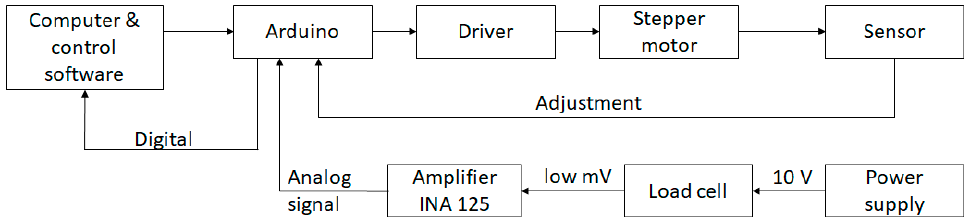
Figure 3. Scheme of fatigue testing machine (FTM)’s main components and electrical connections.